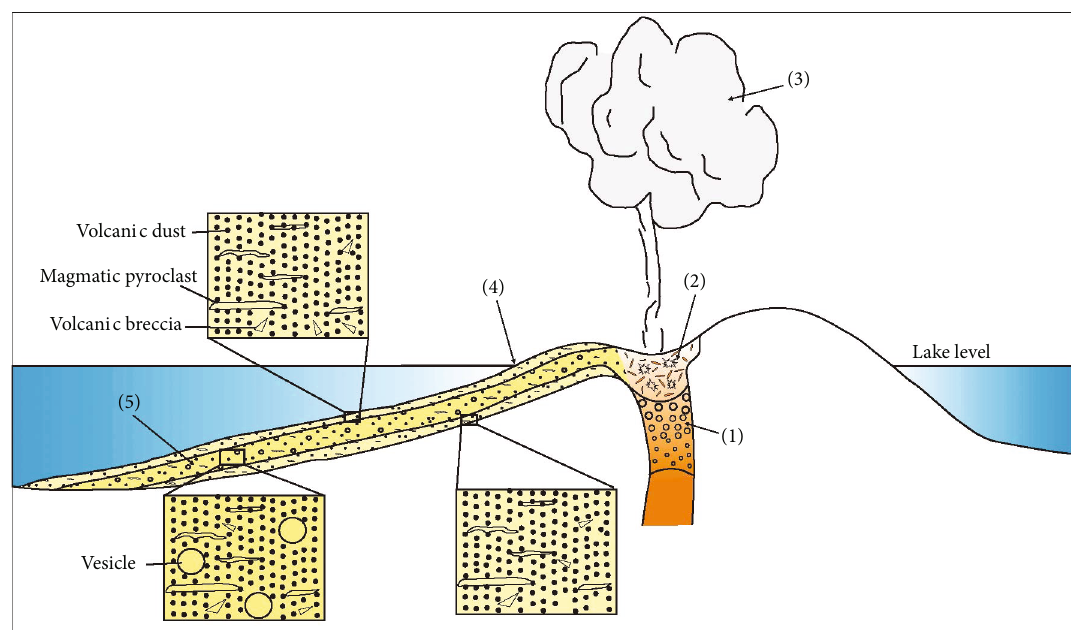
Figure 4: Schematic of the formation mechanism of fused breccia tu ff vesicles in the Wuxia region, modi fi ed according to literature [32]. Numbers indicate the formation process of the vesicles: (1) magma rises volatile material foam, (2) explosion at the surface, (3) a small part of the volcanic dust and pyroclastic material is erupted into the upper atmosphere, (4) the hot magma fl ows into the lake, and (5) high-pressure water vapor is squeezed into the pyroclastic fl